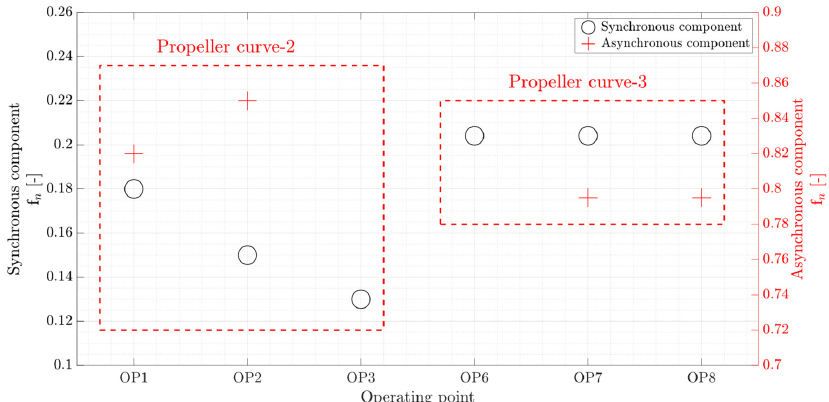
Figure 20. Variation of RVR frequencies obtained from amplitude spectra of pressure transducer P-PS-3 at six operating points.